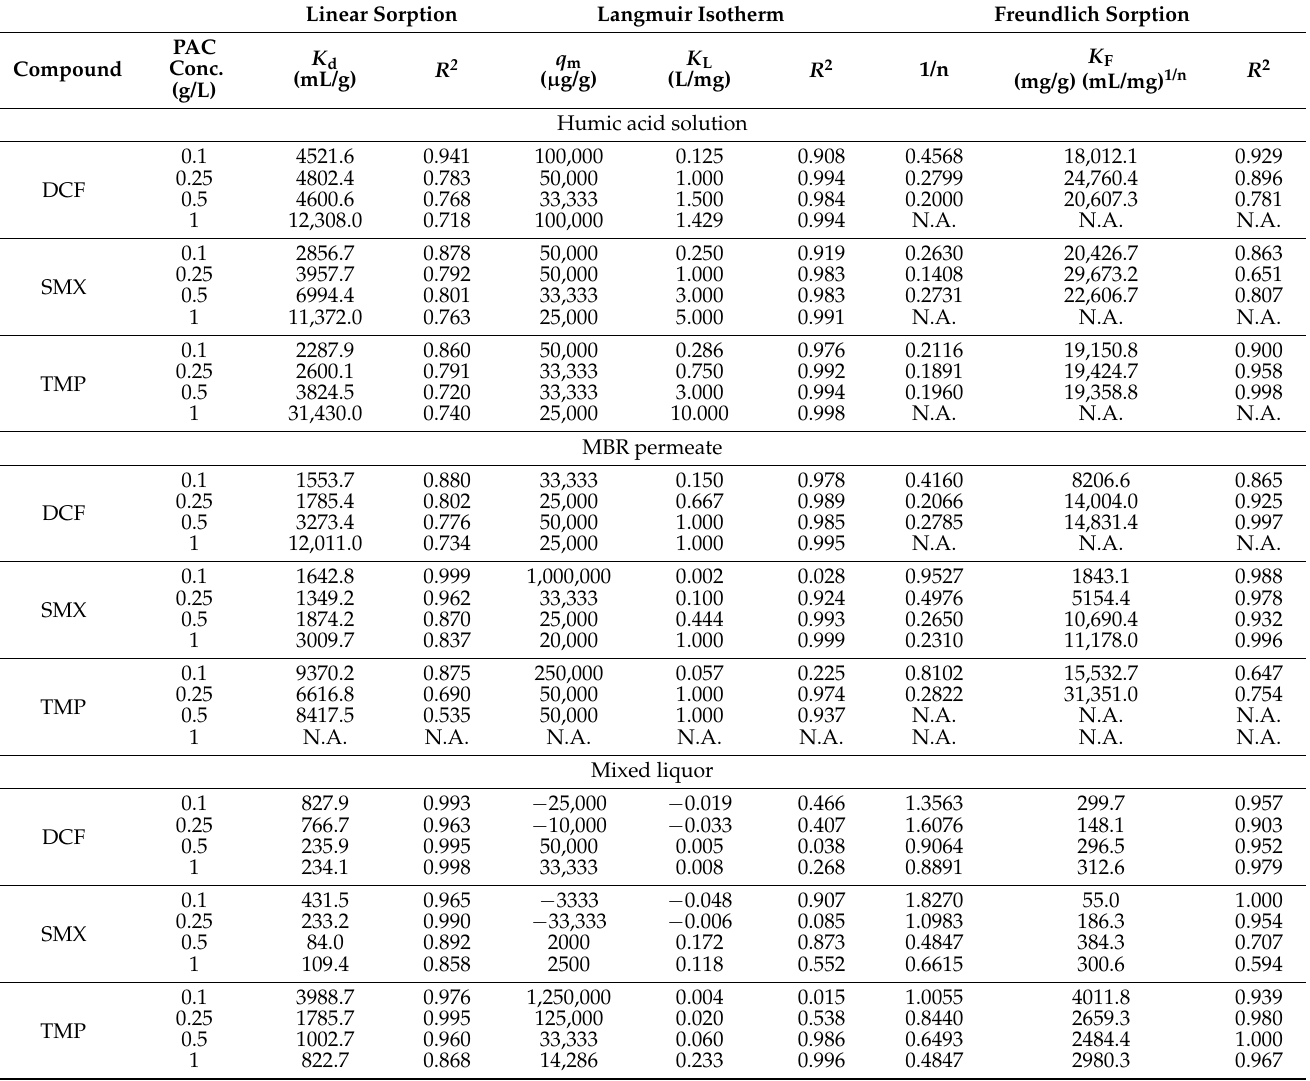
Table 5. Distribution coefficient ( K d ), Langmuir and Freundlich isotherm constants in different water matrices (humic acid solution, MBR permeate and mixed liquor). Results for humic acid solutions were considered without pre-contact time between the HAs and the pharmaceuticals. N.A. (not applicable) indicates that the parameters could not be obtained, as the residual concentration found in the liquid phase was very low to conduct the